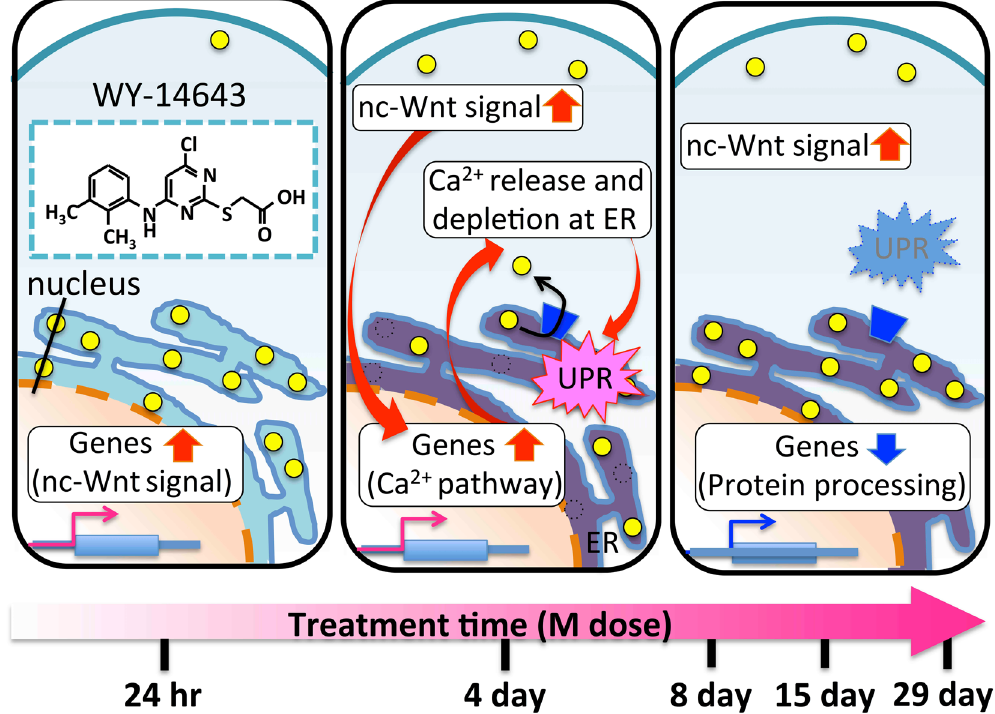
Figure 3. Hypothetical model of the hepatotoxicity caused by WY-14643. Genes in M4vs8_cluster1 were upregulated predominantly in M24hr and M4. This results in elevated sensitivity of beta-catenin independent Wnt signaling and induction of Ca 2 + pathway-related genes, followed by decreasing intracellular Ca 2 + and Ca 2 + release from ER in M4. Upregulation of genes in M4vs8_cluster3, which were also upregulated by amlodipine, implies the Ca 2 + dynamics dysregulation in M4. Also, temporary upregulation of genes in M4vs8_cluster2 in M4 implies UPR response, which is a survival signalling from ER stress that can be caused by Ca 2 + depletion at ER 31 . By long-term treatment of WY-14643 (M8, M15, M29), upregulation of genes in M4vs8_cluster1 (enriched pathways: “beta-catenin independent Wnt signalling”) and downregulation of genes in M4vs8_cluster 2 (enriched IPCs: “Protein processing in ER”) were observed. Since beta-catenin dependent Wnt signaling directly regulates cell cycle 32 and beta-catenin independent Wnt signalling (non-canonical Wnt signalling, which is represented as “nc-Wnt signal” in Fig. 3) antagonises beta-catenin dependent Wnt signalling 33, 34 , it is implied that WY-14643 disrupts proper cell cycle regulation by inducing genes in beta-catenin independent Wnt signaling, while causing organelle proliferation by persistently activating PPAR α signalling. The high- resolution image file is available at Scientific Reports